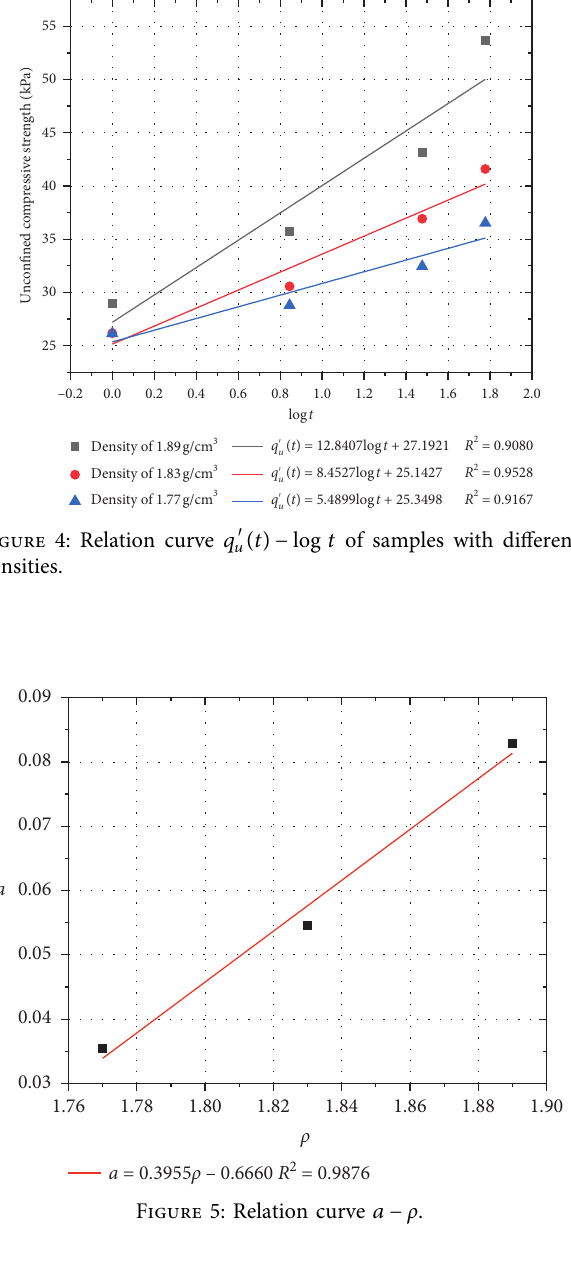
Figure 5: Relation curve a − ρ .